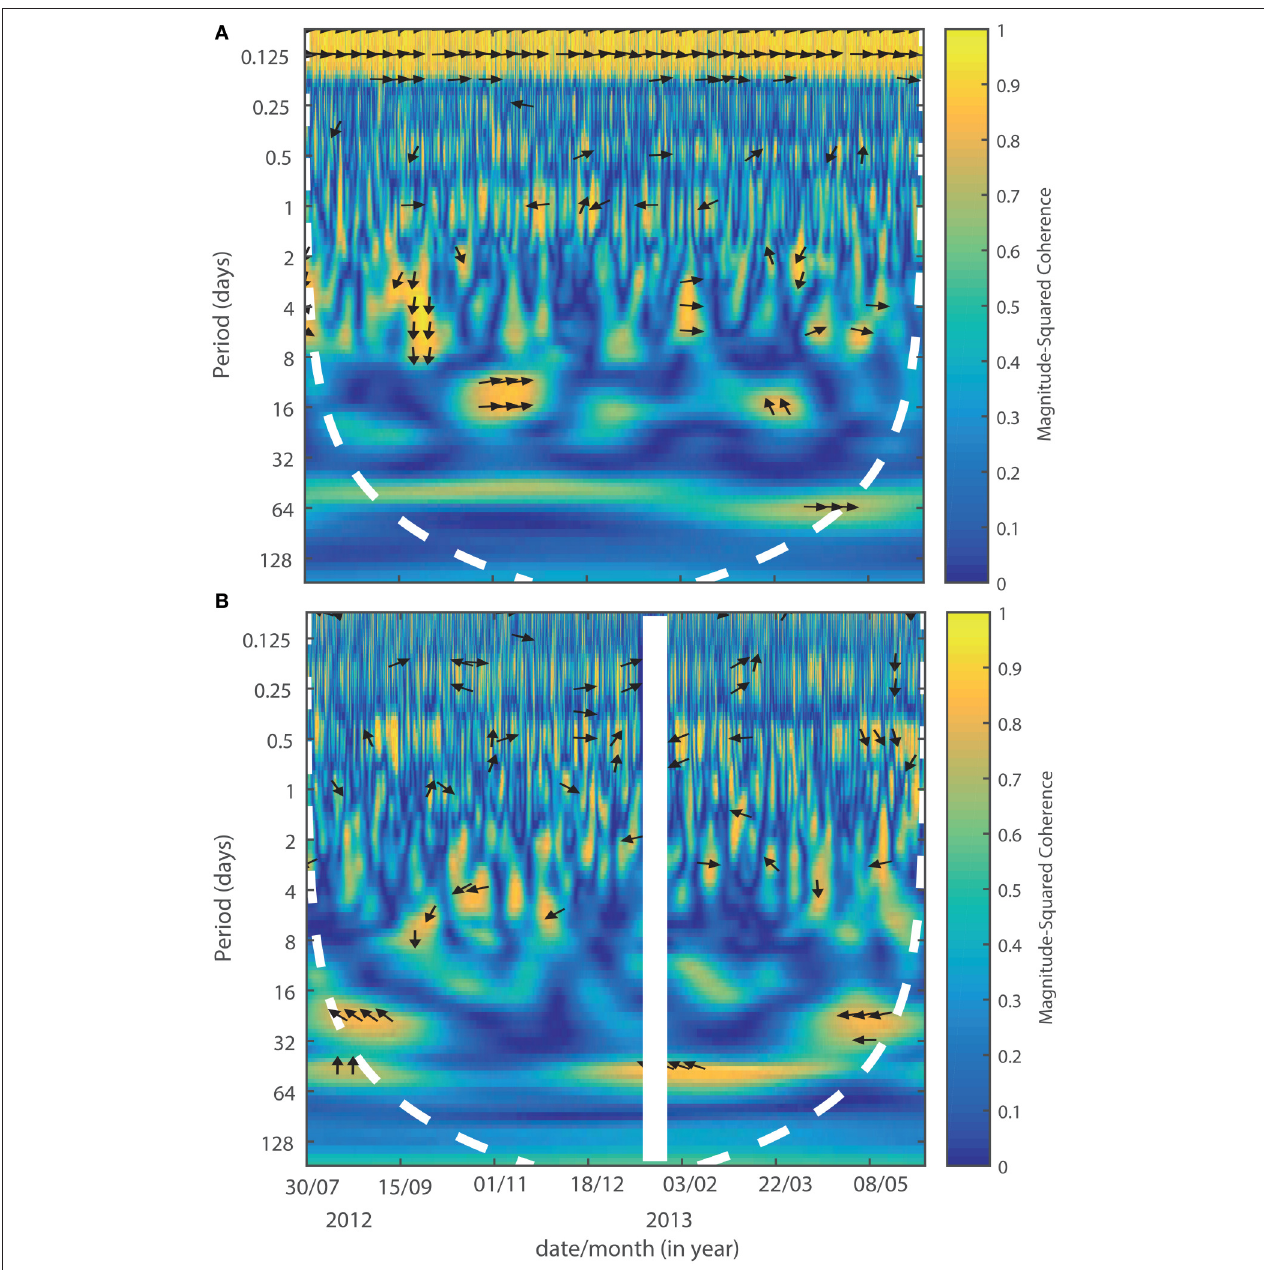
FIGURE 10 | Spectral cross-wavelet power (A) between surface current speed (U, ms − 1 ) and wind speed ms − 1 and (B) between surface current speed (U, ms − 1 ) and river discharges (m 3 s − 1 ). The white dashed lines indicate coherent oscillations at significance level of P < 0.05, and the arrows indicate the relative phase relationship between series in a portion of the time domain (right = in-phase, left = anti-phase, down = first series leads the second by 90 ◦